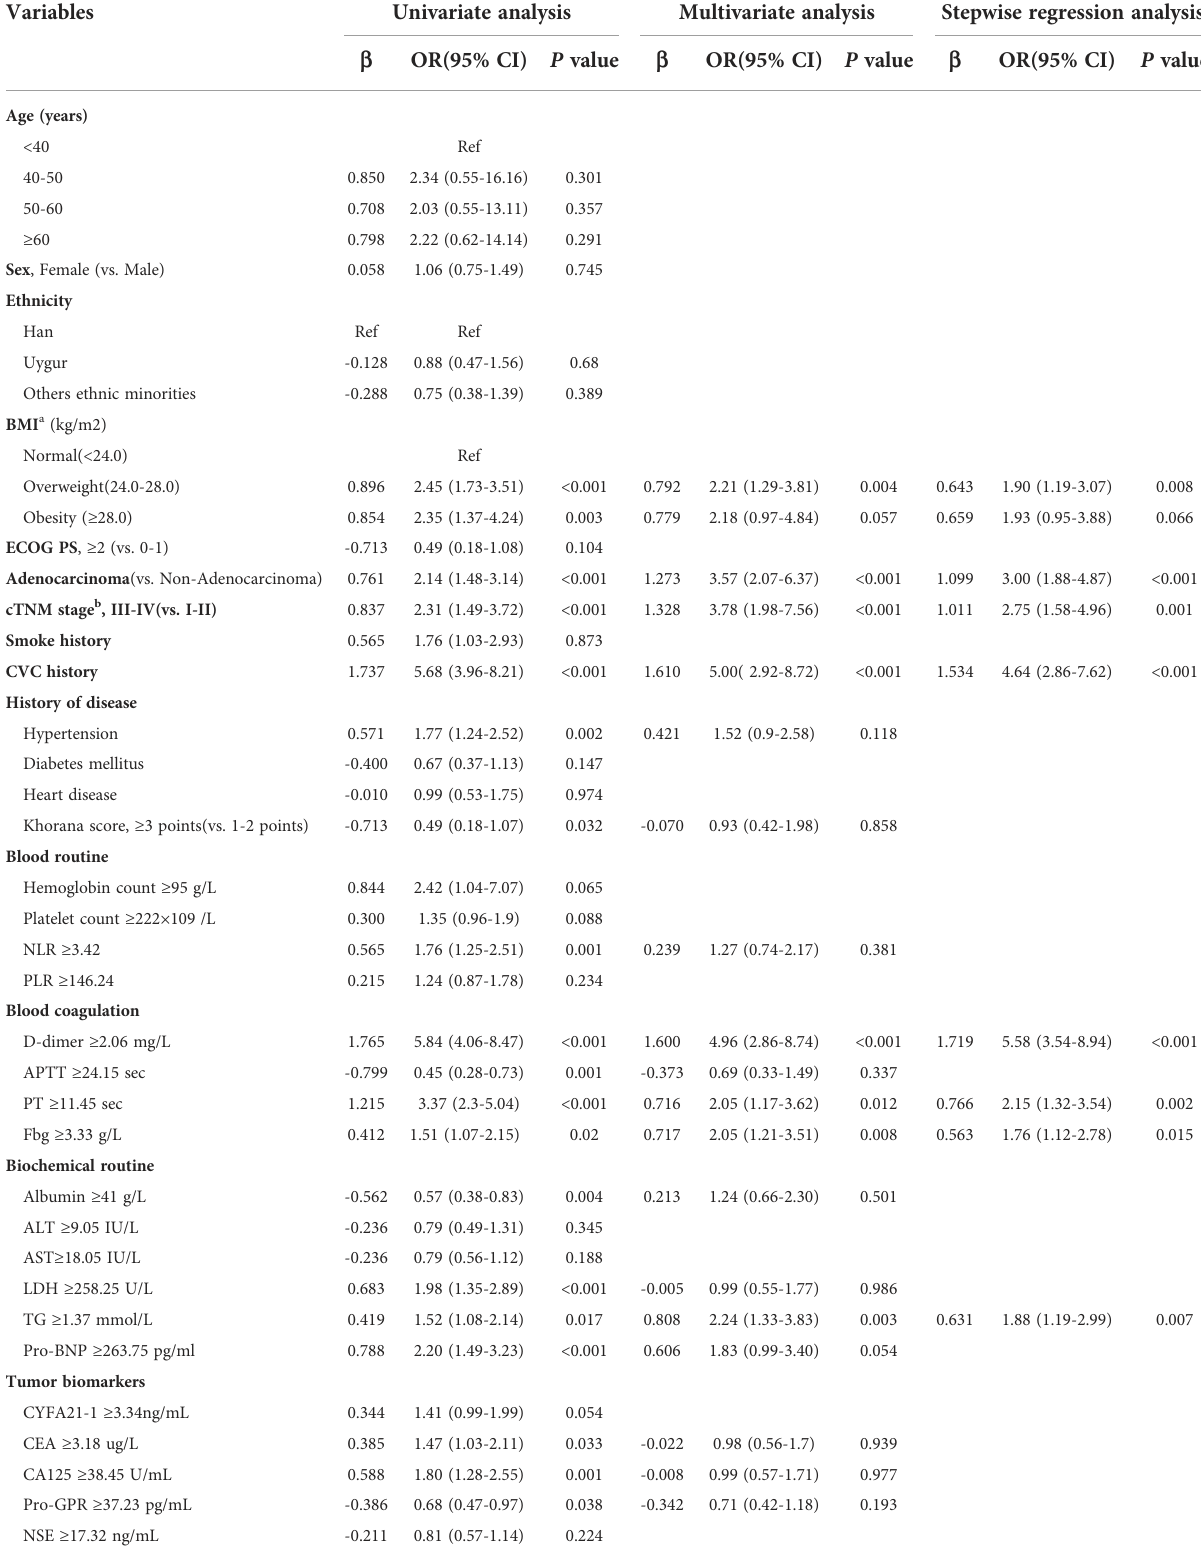
TABLE 2 Univariate and multivariate regression analysis of risk factors associated with VTE in lung